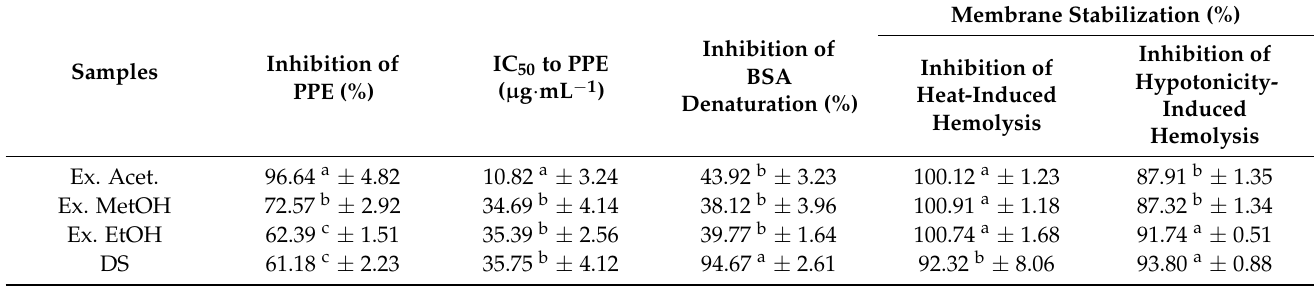
Table 8. In vitro anti-inflammatory activity screening by inhibition of heat-induced hemolysis and inhibition of hypotonicity-induced hemolysis of extracts from the microalga Navicula incerta